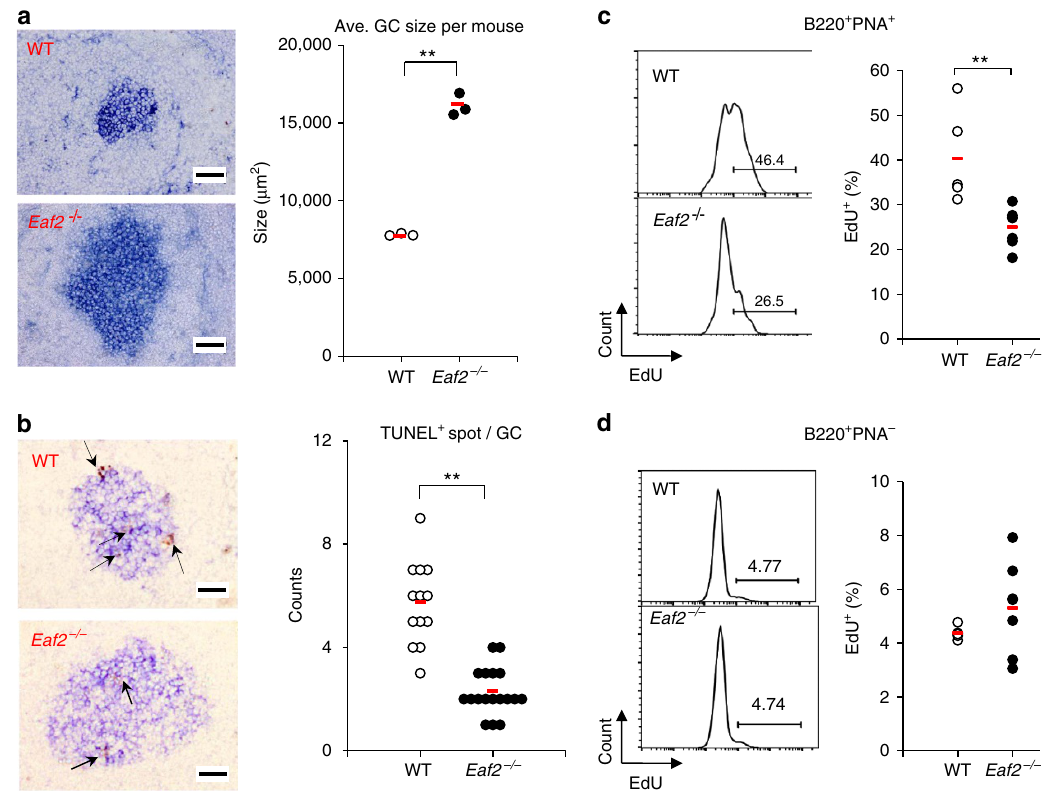
Figure 3 | Eaf2 (cid:3) / (cid:3) mice have enlarged GC with decreased apoptosis compared with WT mice. GC formation in the spleen on day 14 after primary immunization with NP–CGG. ( a ) Left, representative PNA staining (blue) of spleen sections in WTand Eaf2 (cid:3) / (cid:3) mice. Right, average size of GC in each mouse. Over 20 GC were measured in each mouse and the average size was calculated. Each symbol represents the average GC size in one mouse. The results of three pairs of WTand Eaf2 (cid:3) / (cid:3) mice are shown. ( b ) Left, representative TUNEL staining (brown spots indicated by arrows are TUNEL þ ), Right, TUNEL þ spot numbers per each GC. Brown TUNEL þ spots in 7–10 GC of each mouse were counted. The results of two pairs of WTand Eaf2 (cid:3) / (cid:3) mice are shown. For both a and b , original magnification: (cid:2) 200. Bars, 50 m m. ( c ) EdU incorporation by B220 þ PNA þ GC B cells in WTand Eaf2 (cid:3) / (cid:3) mice. Left, representative FACS profiles of EdU levels; right, results of 5 WTand 6 Eaf2 (cid:3) / (cid:3) mice. ( d ) EdU incorporation by B220 þ PNA (cid:3) non-GC B cells in WTand Eaf2 (cid:3) / (cid:3) mice. The red bar indicates the mean value of each group. ** P o 0.01 (unpaired t -test). NATURE COMMUNICATIONS|7:10836|DOI: